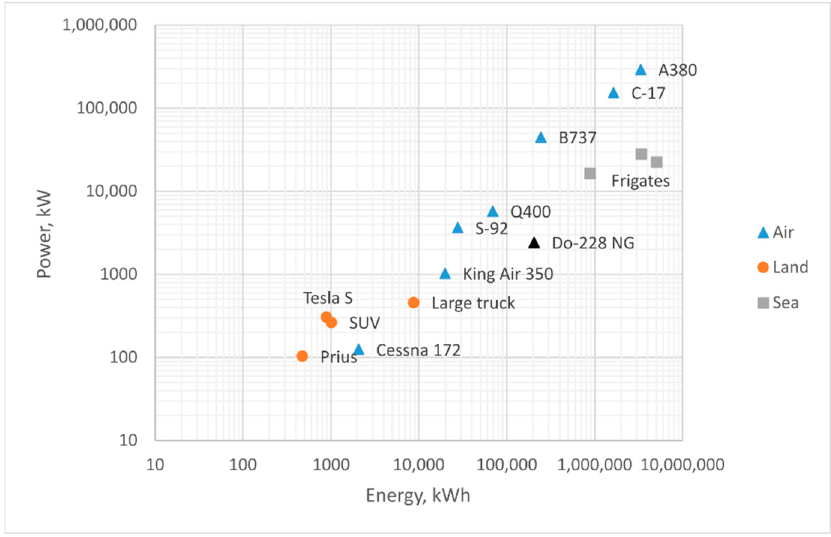
Figure 1. Power and energy required for vehicles ranging from small cars to large commercial Figure 1. Do-228NG design mission aircraft [1,14].